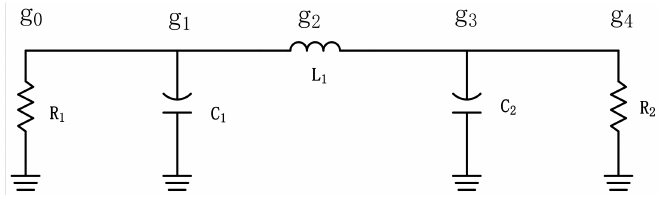
Figure 2. Structure of the low-pass filter prototype